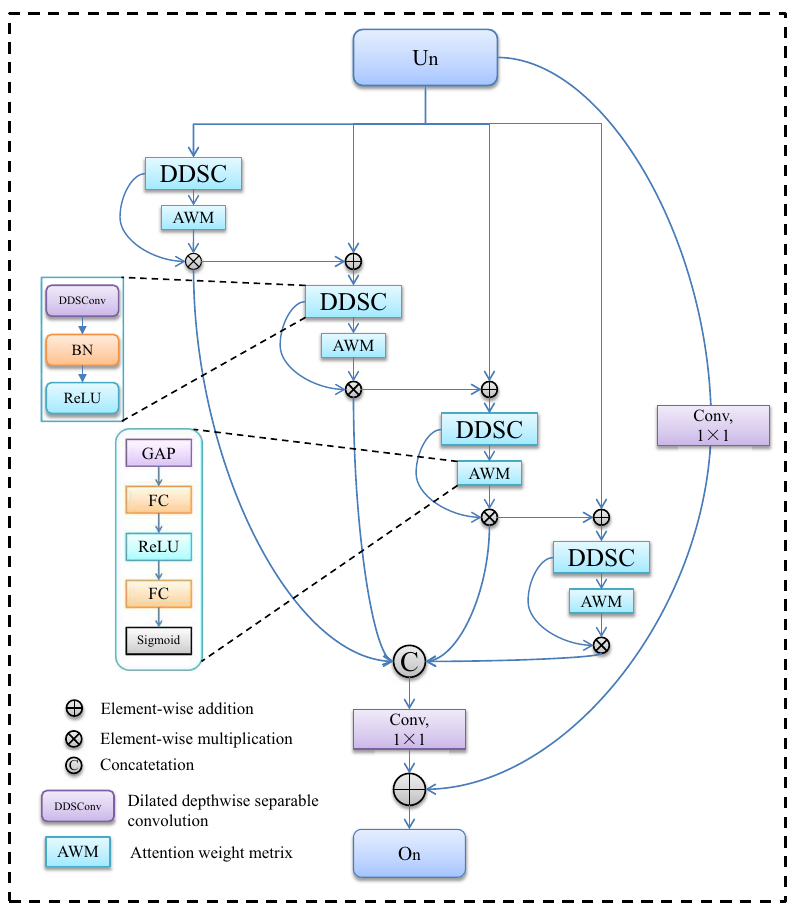
Figure 4. Detailed illustration of the proposed Multi-Scale Contextual Attention Module